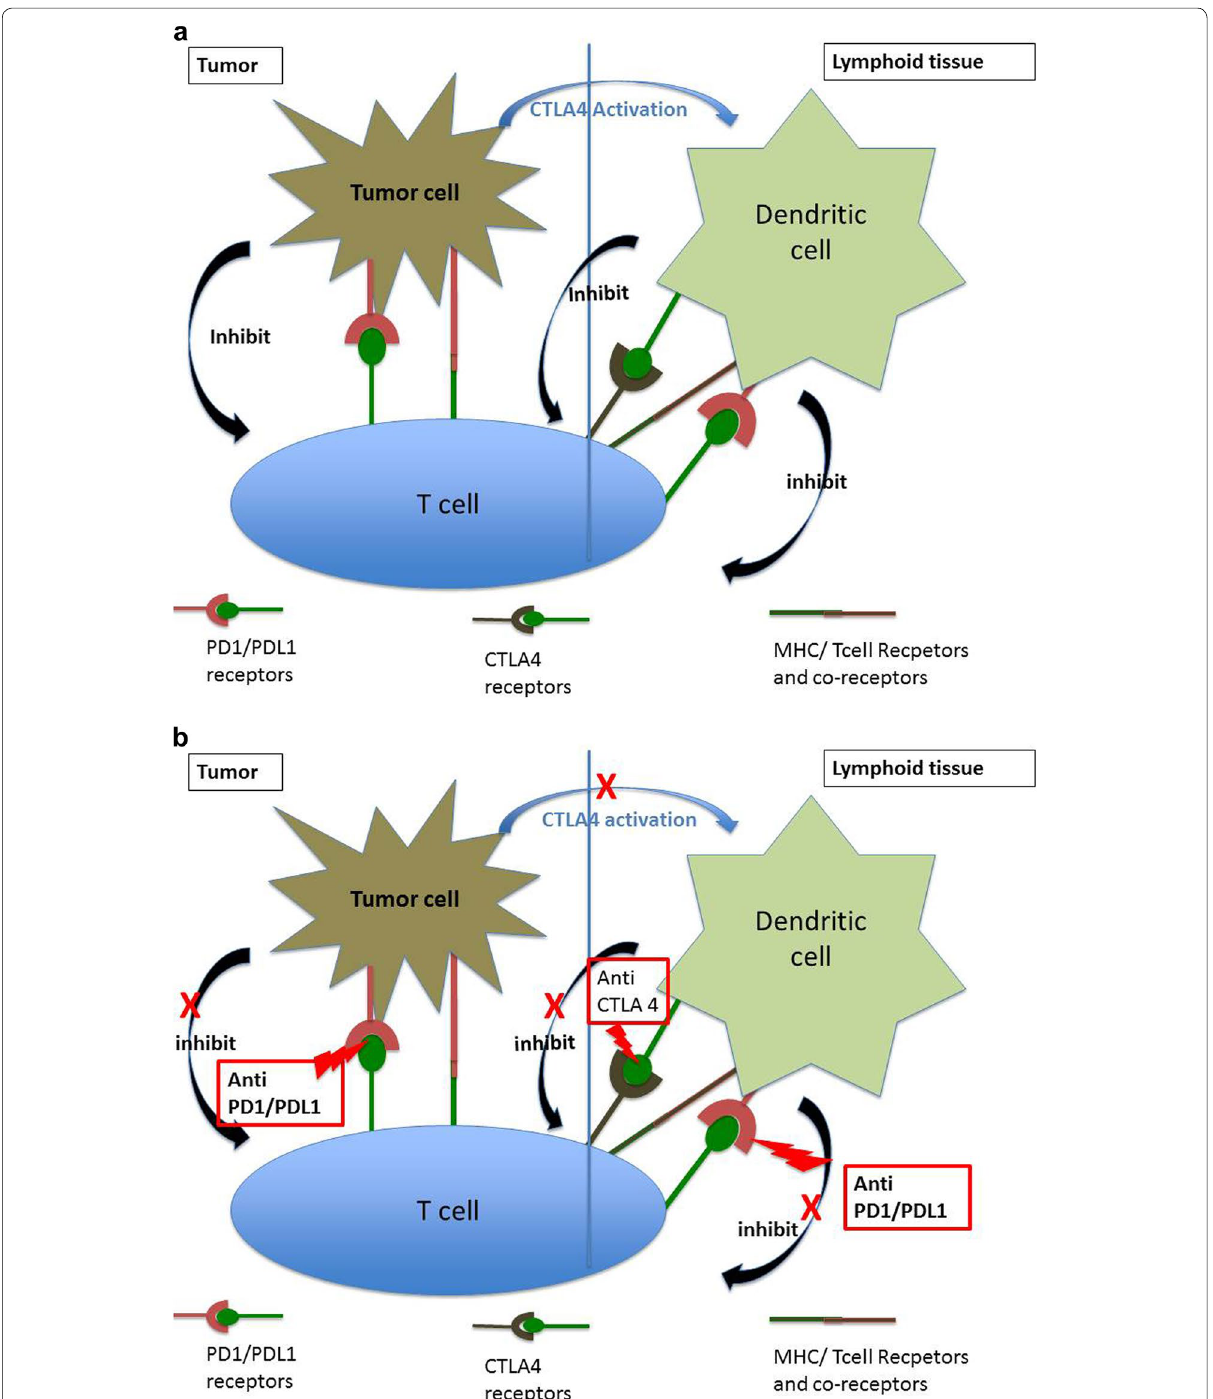
Fig. 1 Checkpoint inhibitors: mode of action. a Tumor cell inhibition of the immune system: tumor cells decrease T cell activation via two pathways. Within the tumor, connection between tumor cell PDL‑1 and T cell receptor PD‑1 associated with MHC T cell receptor leads to inhibition of T cell function. Within the lymphoid tissue, tumor cells inhibit dendritic cells via the CTLA‑4 pathway. Cancer cells increase CTLA4 expression by dendritic cells, through T reg cell stimulation. Interaction of CTLA4‑Receptor on T cell, inhibits T cell function [1]. b Mode of action of CTLA‑4i or PD‑1/PDL‑1i. PD‑1/PDL‑1i blocks the connection between PD‑1 and PDL‑1 and prevents the inhibition of T cells. T cell cytotoxicity then attacks the tumor cells. CTLA‑4i blocks the connection between dendritic cells and T cells related to CTL14. CTLA‑4i removes the inhibition related to dendritic cell on T